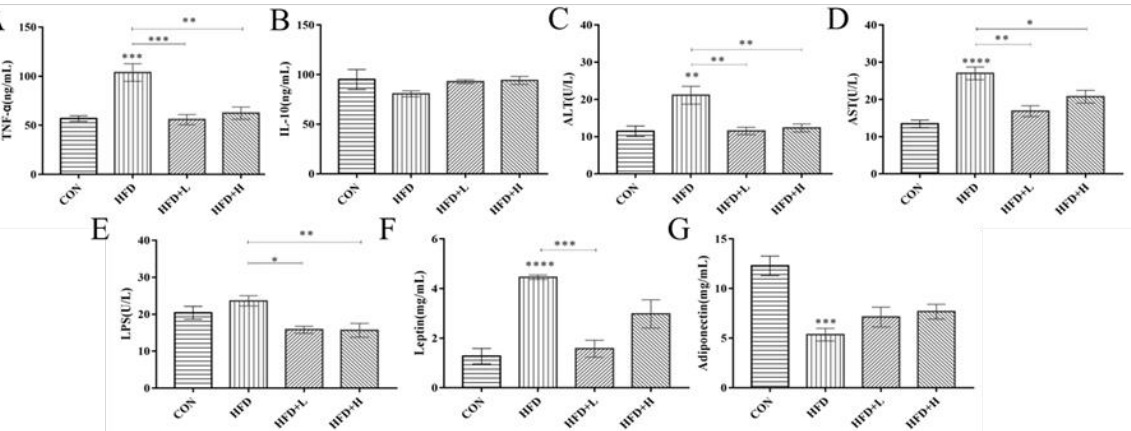
Figure 5. Effect of CIP on serum cytokine in HFD-fed mice ( n = 5). ( A ) TNF- α, ( B ) IL-10, ( C ) ALT, ( D ) AST, ( E ) LPS, ( F ) leptin, and ( G ) adiponectin. Data were shown as mean ± SEM. * p < 0.05, ** p < 0.005, *** p < 0.001, and **** p < 0.0001 compared with the other groups.